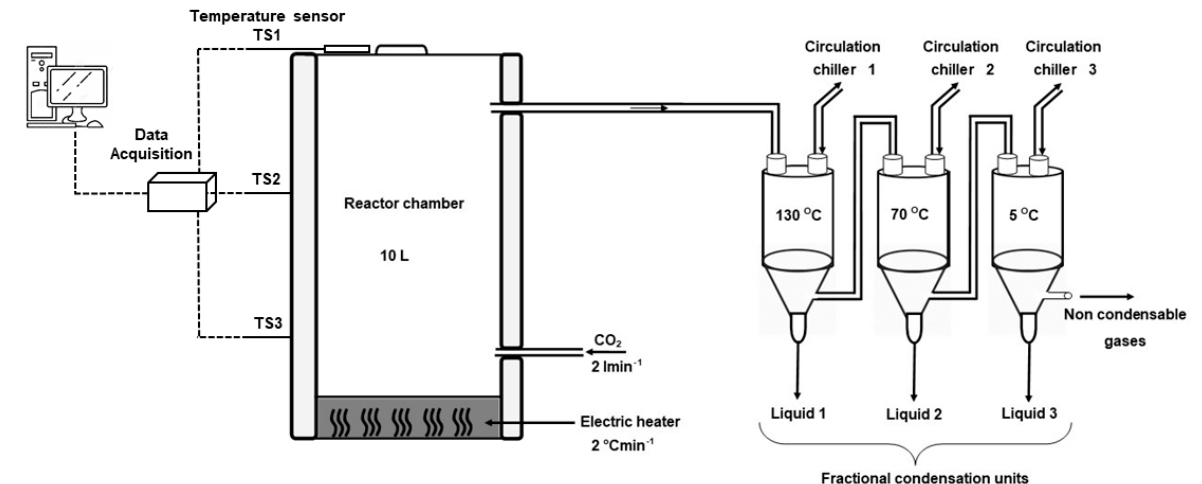
Figure 1. Schematic diagram of stepwise slow pyrolysis process .